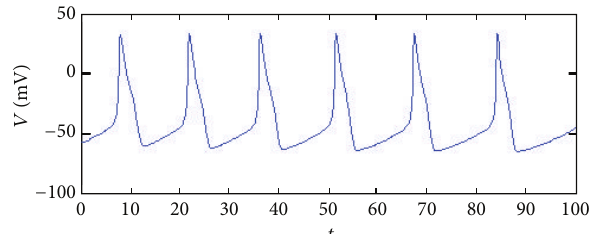
Figure 4: Membrane potential of a GC when 𝑔